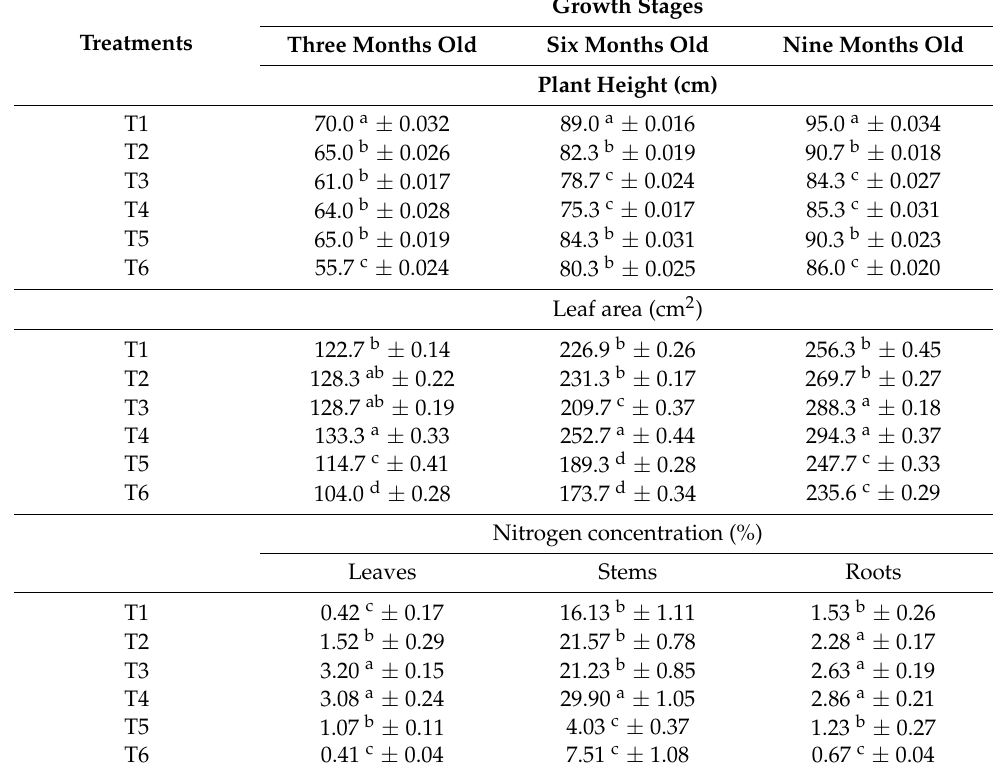
Table 6. Vegetative growth and nitrogen concentration in leaves, stems, and roots of Ananas comosus L. Merr var. Moris at harvest cultivated in a tropical peat soil treated with clinoptilolite zeolite and compound NPK fertilizer.